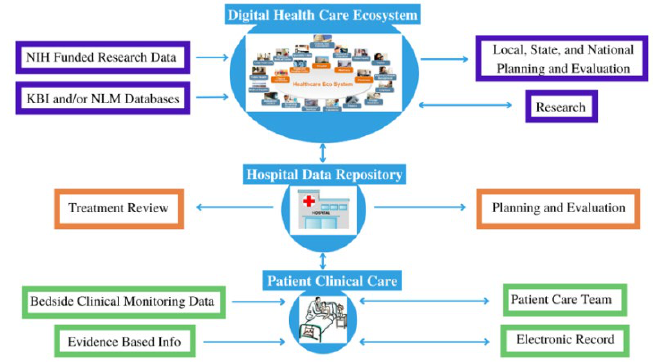
Figure 5 Learning Health System in Support of a Hospital Patient’s Clinical Care and